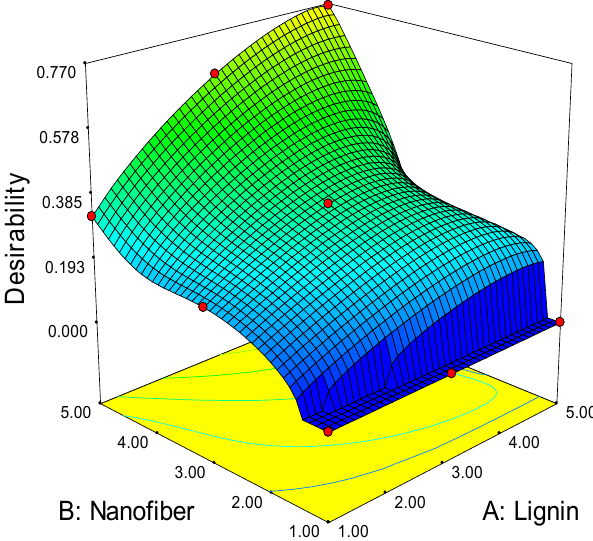
Figure 5. Desirability function of selecting the ideal film prepared.